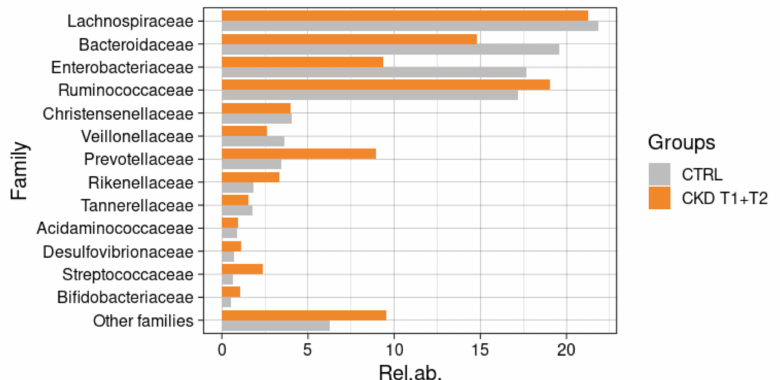
Figure 7. Taxonomic composition of the gut microbiota of healthy subjects and CKD at baseline. Barplots of average microbial relative abundances at family level for the control group (CTRL) and CKD patients after 3 and 6 months of Meriva ® supplementation (respectively, CKD T1 and T2) grouped